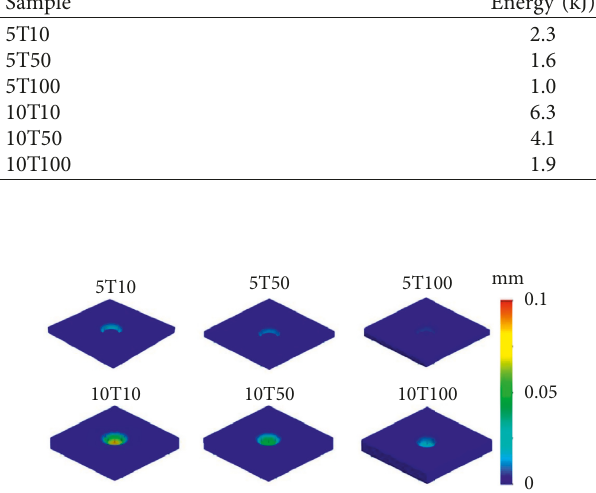
Table 5: Structural analysis results of absorption energy. Sample